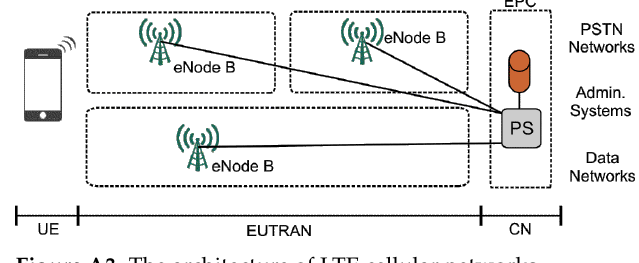
Figure A3. The architecture of LTE cellular